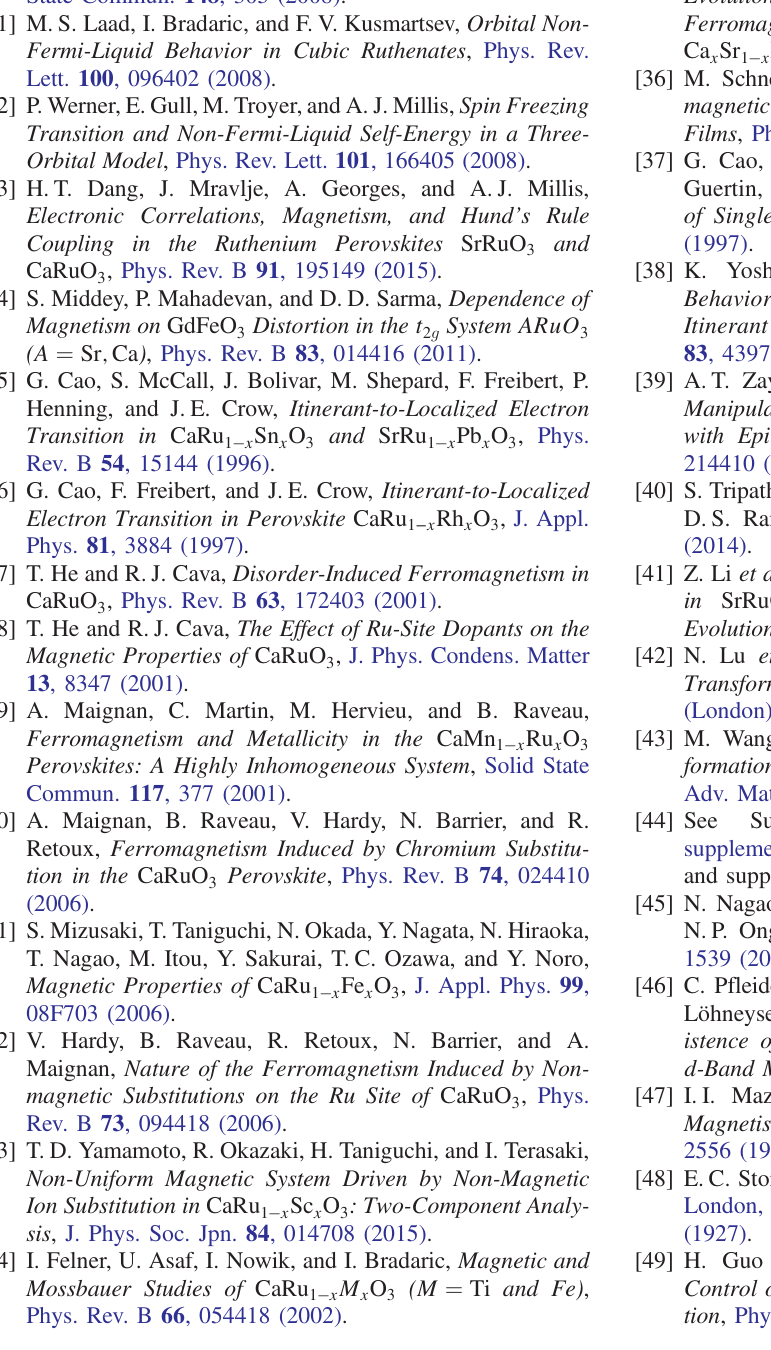
CaRuO 3 : Comparison to Ferromagnetic SrRuO 3 ,